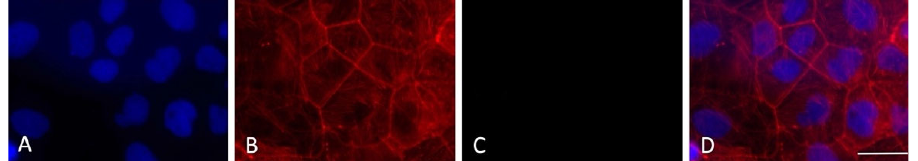
Figure 8. Immunofluorescence staining for nucleocapsid SARS ‐ CoV ‐ 2 protein cells not treated (60× magnification, scale bar 30 micron). The fluorescence for nucleus (blue, ( A )), F ‐ actin cytoskeleton (red, ( B )), nucleocapsid protein of SARS ‐ CoV ‐ 2 (green, ( C )) and the merge of the three channels are displayed ( D ).